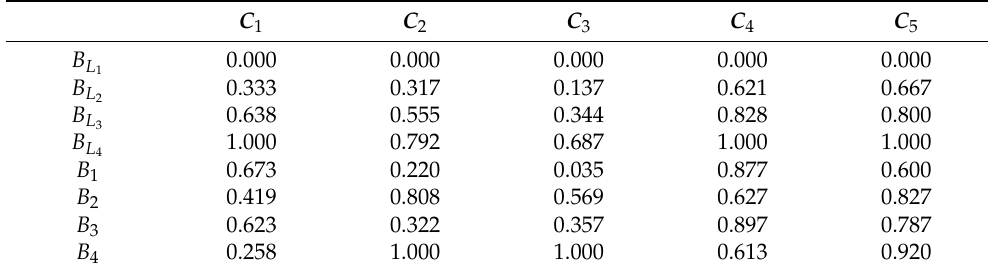
Table 3. Normalized decision-making matrix.